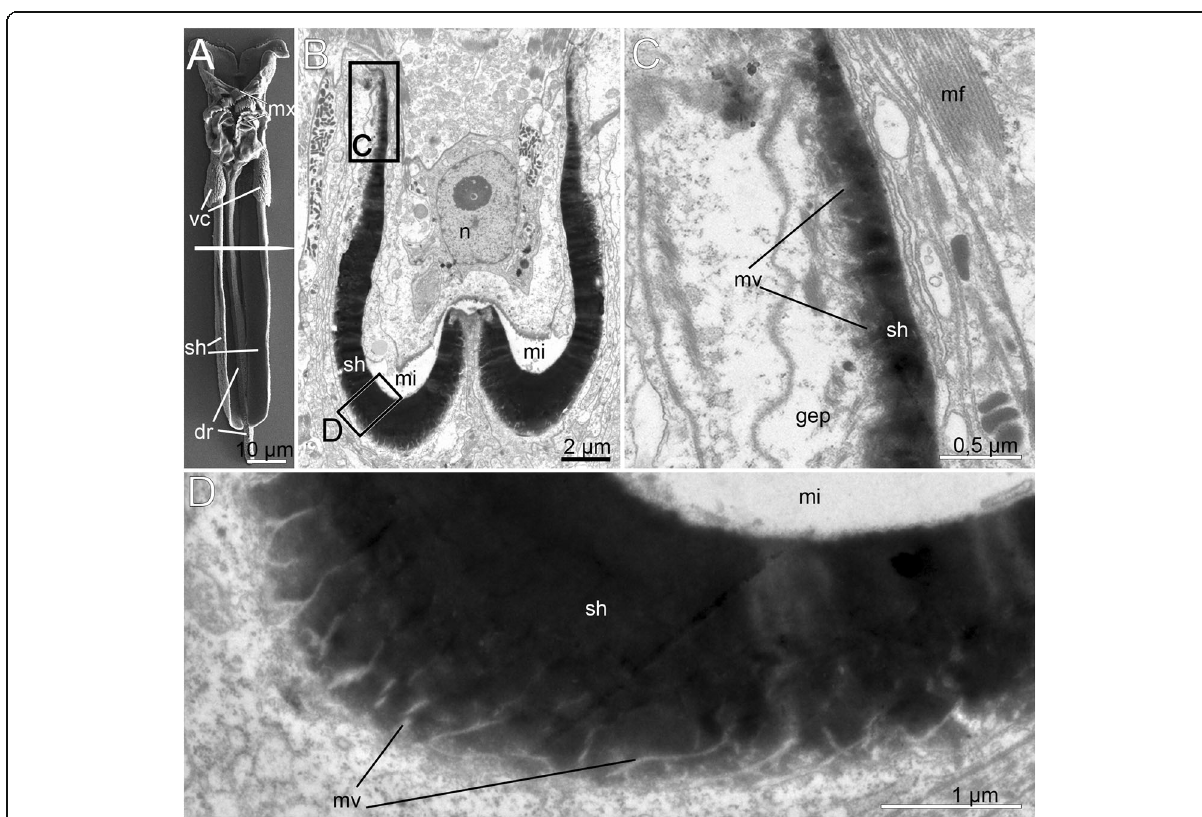
Fig. 8 Fine structure of the adult mandibles of Histriobdella homari . a. Jaws with a maxillary apparatus and mandibles, SEM image of the entire jaw apparatus. The white line indicates the position of the transversal ultrathin sections. b. Ultrastructure of the mandibular shaft; transversal section. The black squares correspond to TEM images shown in ( c ) and ( d ). c . Close -up of the mandibular margin. d . Ultrastructure of the median mandible. dr, dorsal rod; gep, gnathoepithelial cell; mi, median VPO invagination; mv, zone with microvilli; n, nucleus; sh, mandibular